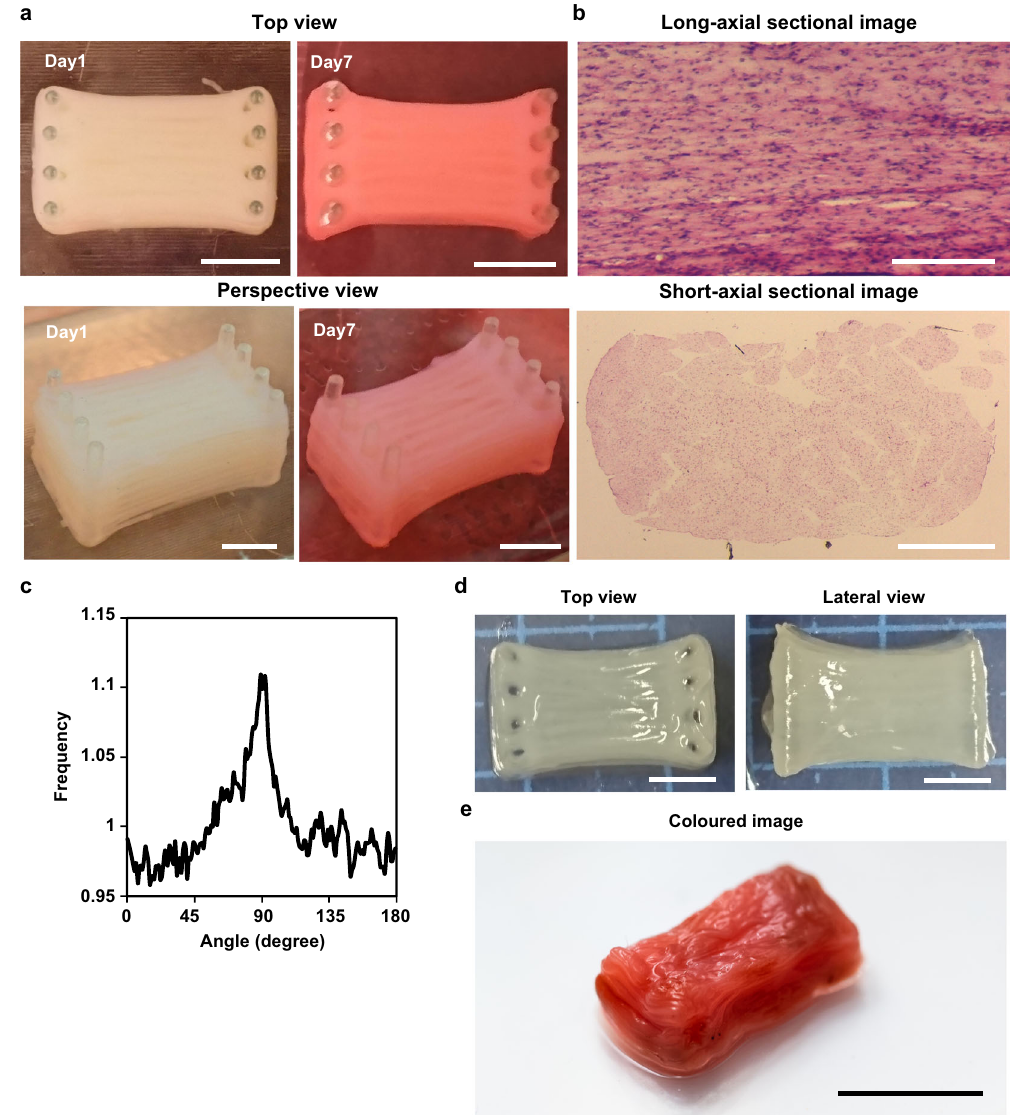
Fig. 3 Morphological analysis of the millimetre-thick bovine muscle tissue. a Images of the millimetre-thick bovine muscle tissue on day 1 and day 7 of culture. The change in colour from Day 1 to Day 7 could be caused by the colour change of the phenol red in the culture medium or difference of the light exposure conditions when taking the photos. b Long-axial sectional image and short-axial sectional image of the muscle tissue stained with haematoxylin and eosin (H&E). c Directional distribution of brightness calculated from FFT images that corresponded to confocal images taken from a bovine muscle tissue constructed by stacking fi ve myocyte-laden hydrogel modules. 0 degree and 180 degree show short-axial direction of the tissue, and 90 degree shows its long-axial direction. d Top and lateral views of the millimetre- thick bovine muscle tissue after release from the pillars. e The millimetre-thick bovine muscle tissue coloured using red food colouring agent. Scale bars, ( a ) 5 mm, ( b ) 0.2 mm (long-axial sectional image), 2 mm (short-axial sectional image), ( d ) 5 mm and ( e ) 1